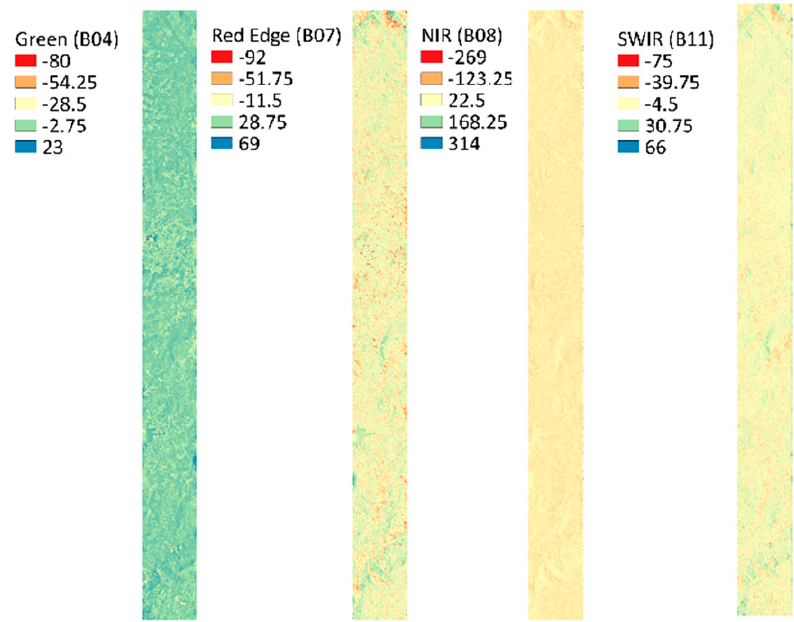
Figure 4. Subtraction values for the overlapping area between the TNG and TPG Sentinel-2 tiles. Tile acquisition date: 19 July 2019. Acquisition satellite: Sentinel-2B. From left to right: B04, the green band of the visible spectrum; B07, Red Edge Region; B08, Near Infrared Region (NIR) band; B11, Shortwave Infrared Region (SWIR).